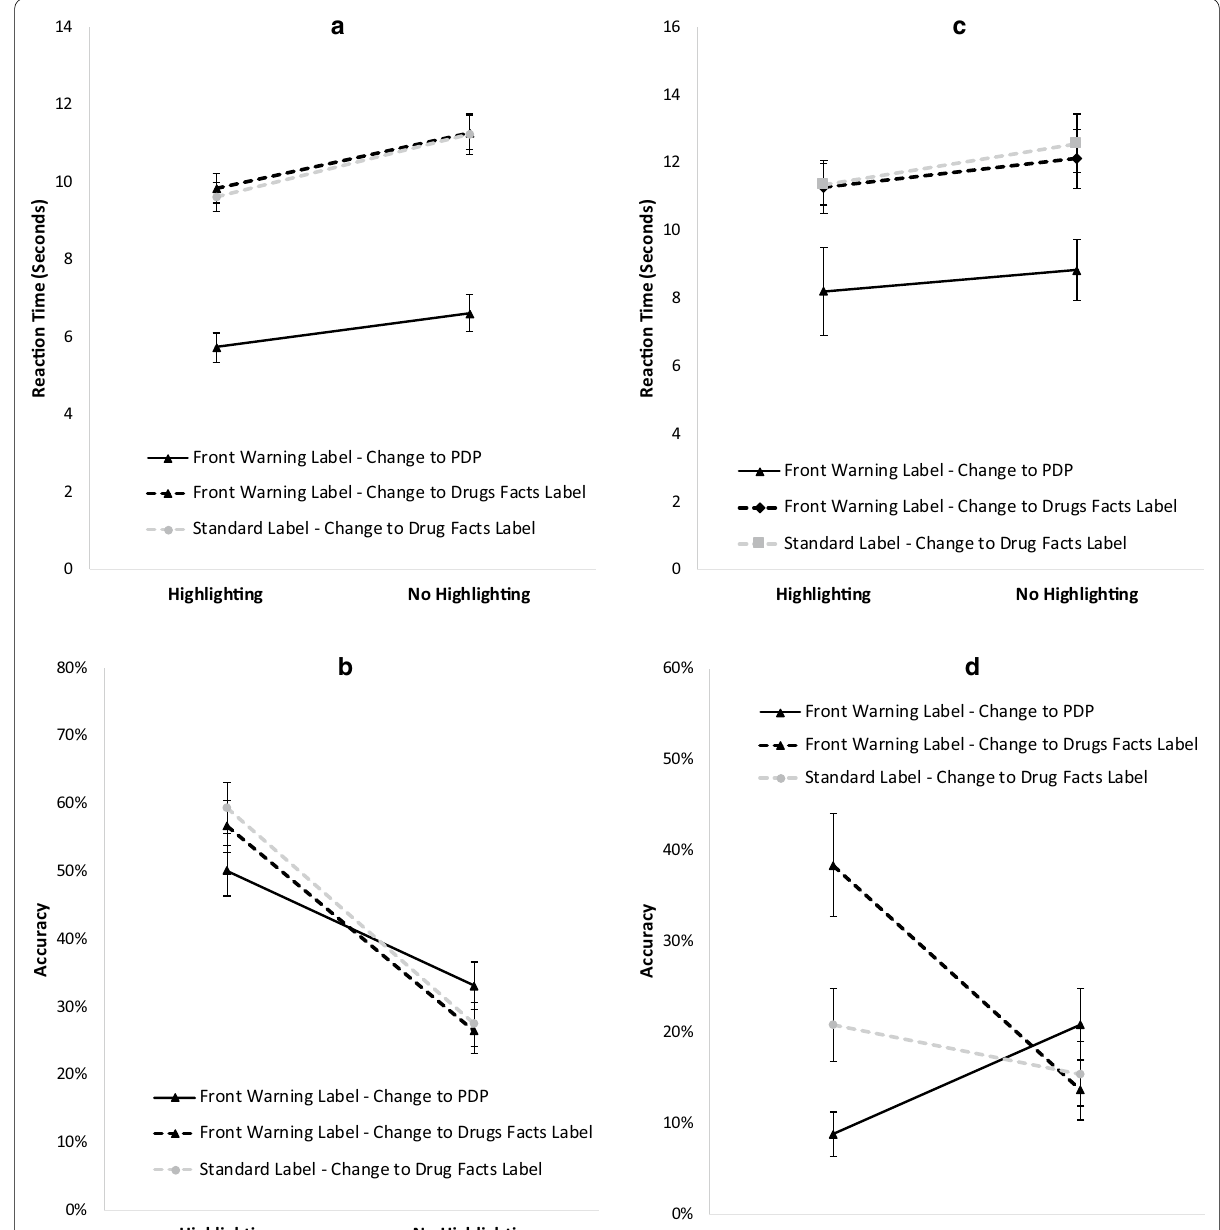
Fig. 6 a The mean reaction time for changes to warnings by condition for Experiment 1. b The corresponding mean accuracy data. c , d present the mean reaction time and accuracy data for changes to warnings by condition for Experiment 2. For accuracy the values are the estimated marginal means. For reaction time, rather than present the log transformed data that was used for the analyses, for illustrative purposes we present the means of the raw data. Error bars represent the standard error of the